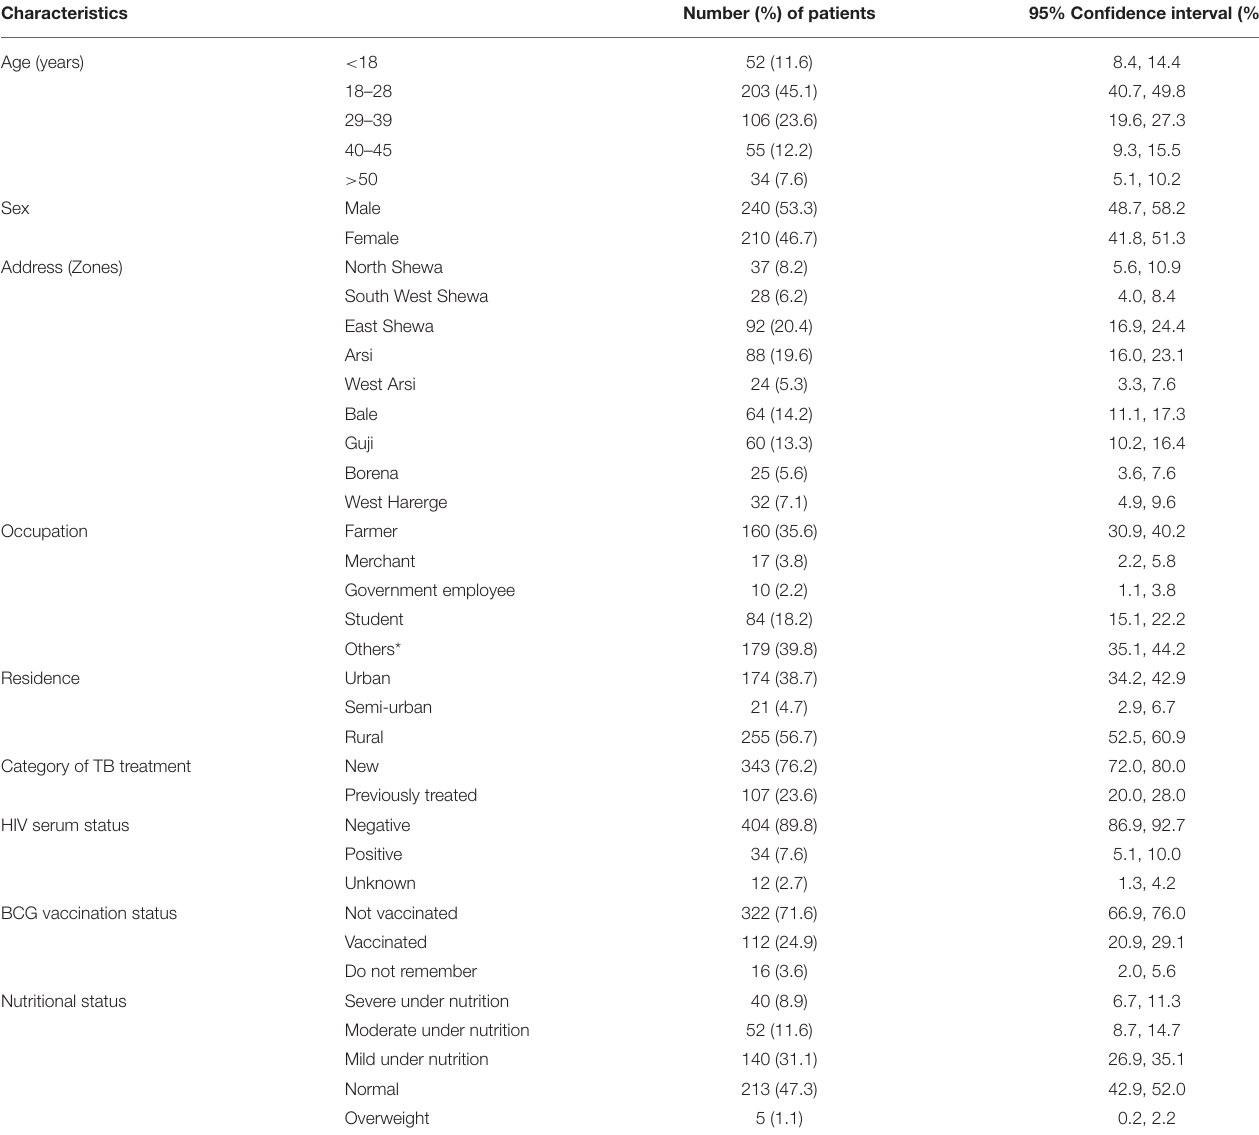
TABLE 1 | Sociodemographic characteristics and clinical history of the study participants, n = 450, Oromia, Ethiopia, 2020.